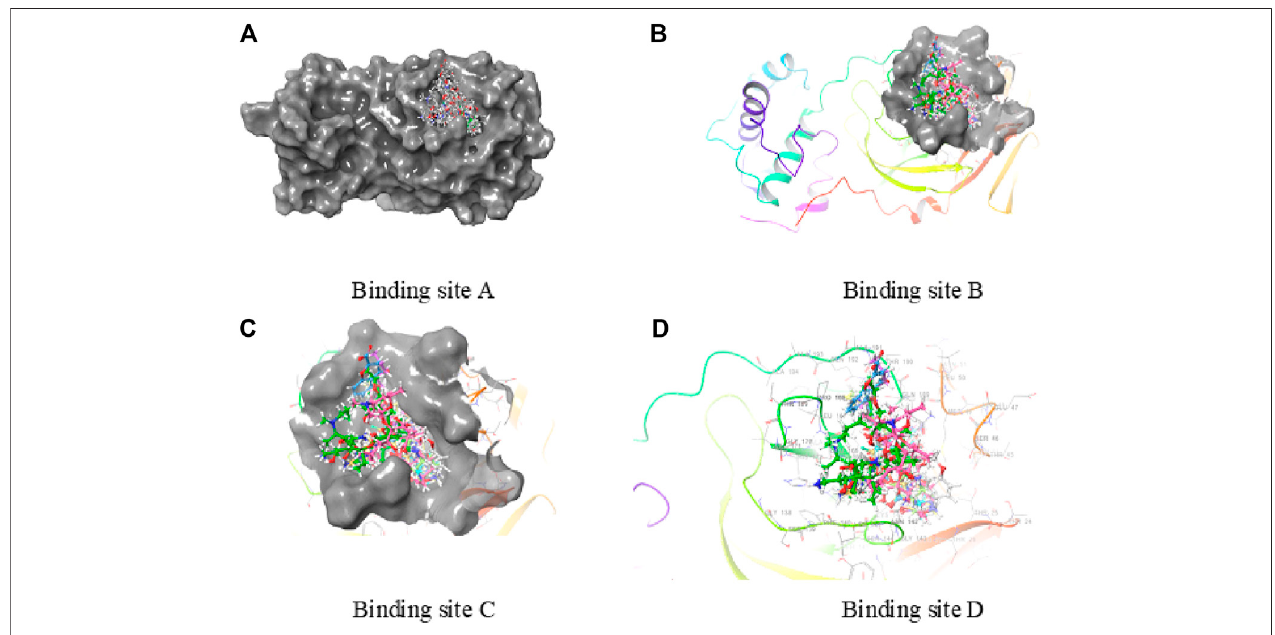
FIGURE 3 | Active binding sites of